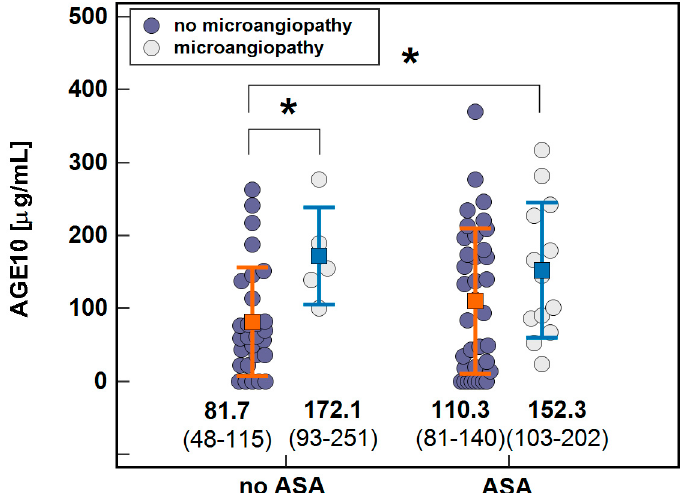
Figure 6. The association of AGE10 with microangiopathy in patients stratified based on aspirin (ASA) treatment. Data presented as means with 95% confidence interval (closed squares with whiskers and figures below the dot-plots) and analyzed using two-way ANOVA. Connectors with asterisks indicate significant ( p < 0.05) between-group differences.